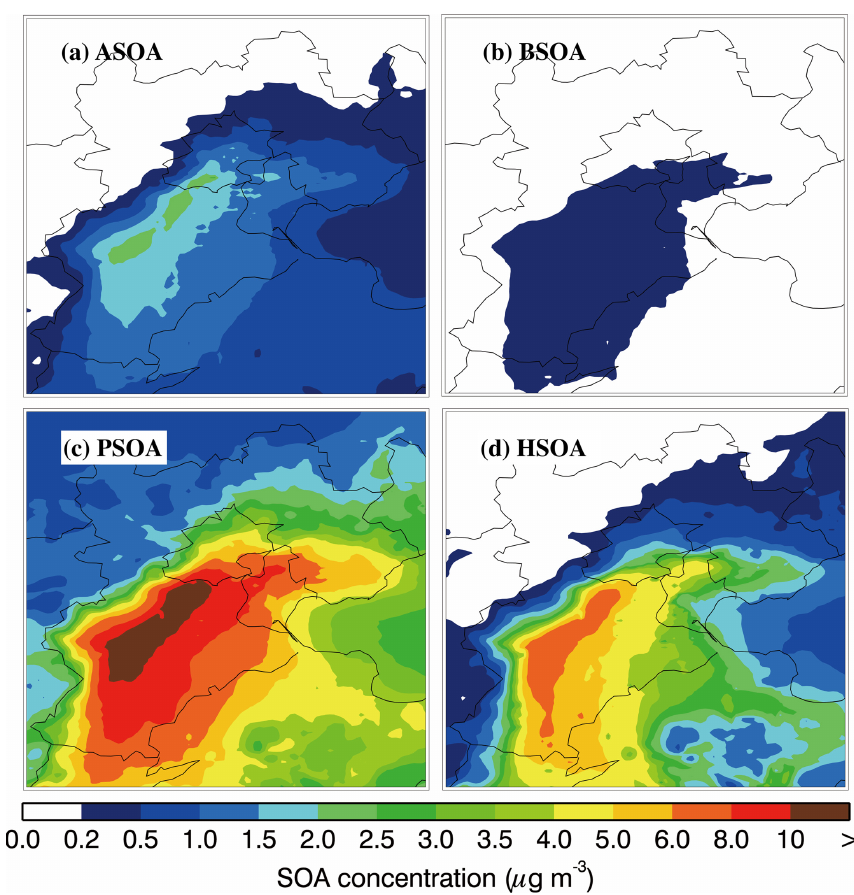
Figure 8. Spatial distribution of the average SOA concentration from different formation pathways of (a) ASOA, (b) BSOA, (c) PSOA, and (d) HSOA during the simulation